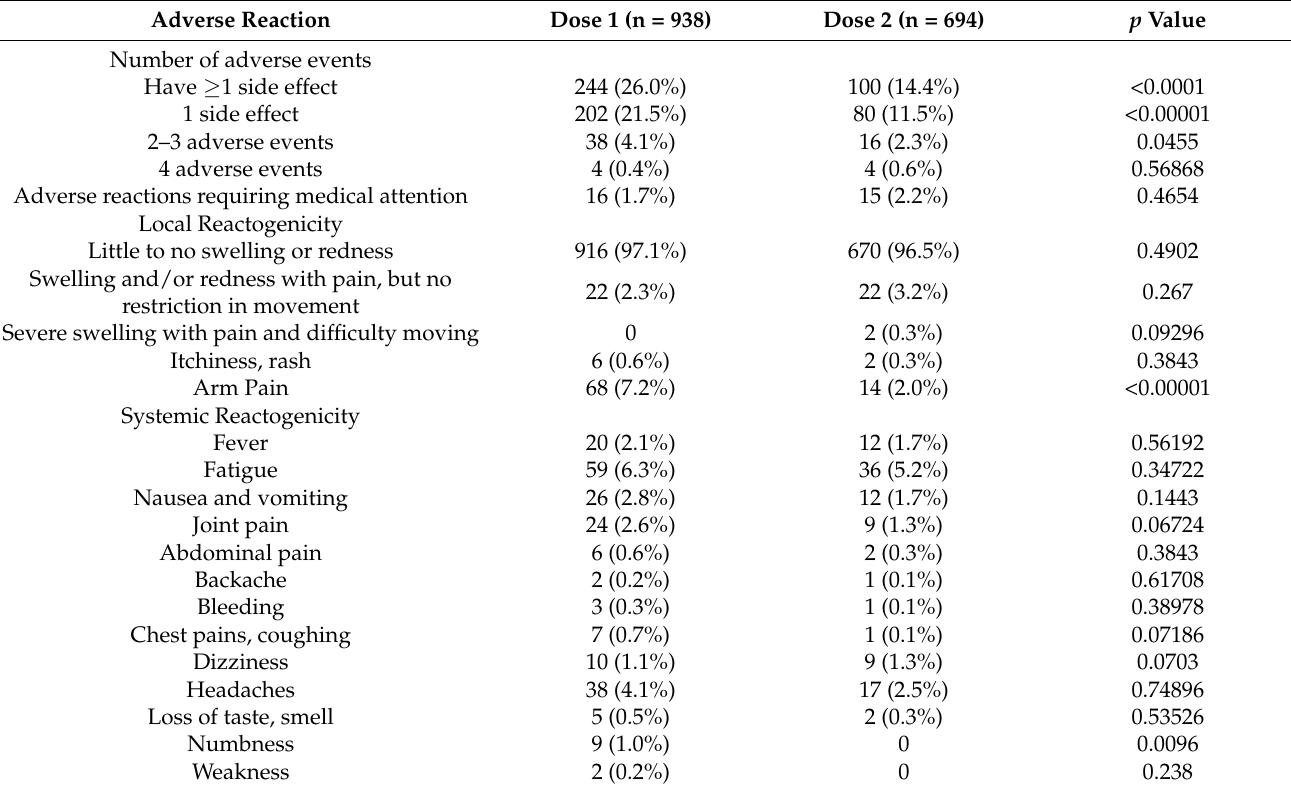
Table 3. Prevalence of adverse events after the first and second vaccination